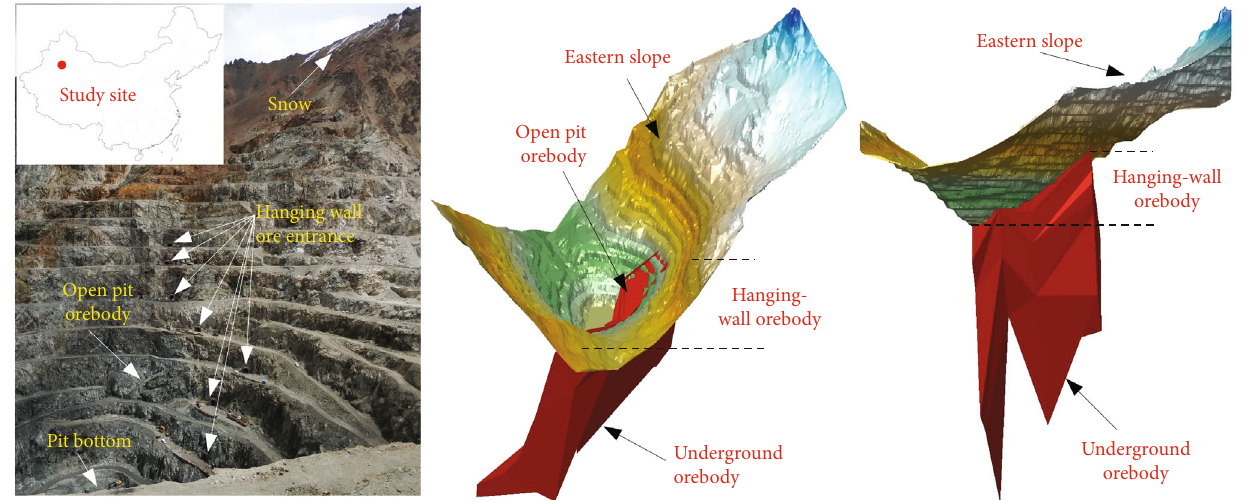
Figure 1: The morphological characteristics of the eastern slope with hanging-wall orebody.